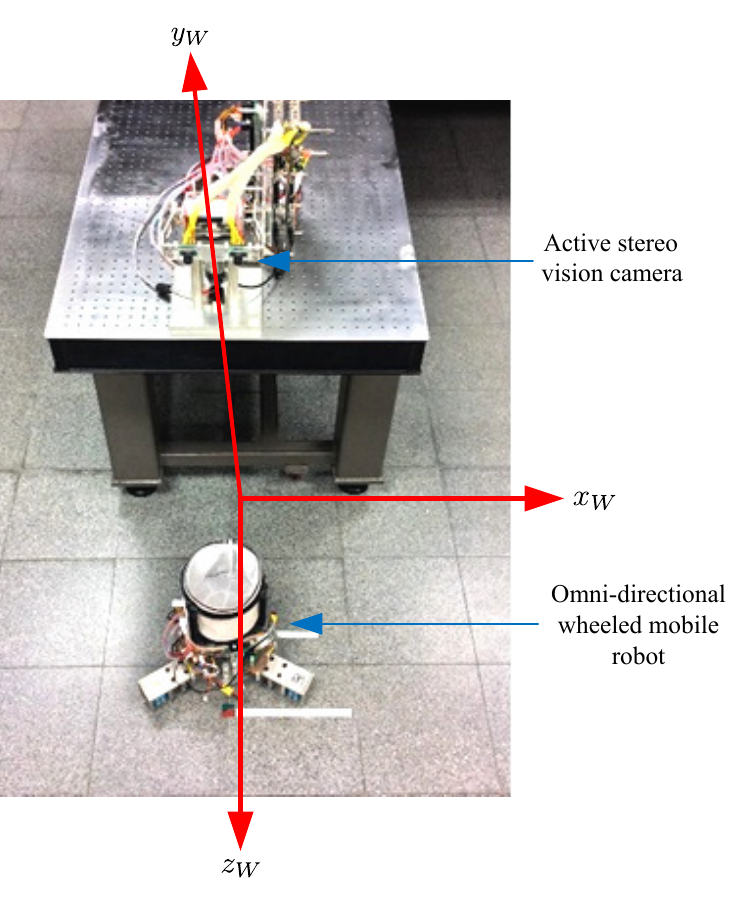
Figure 15. The experimental